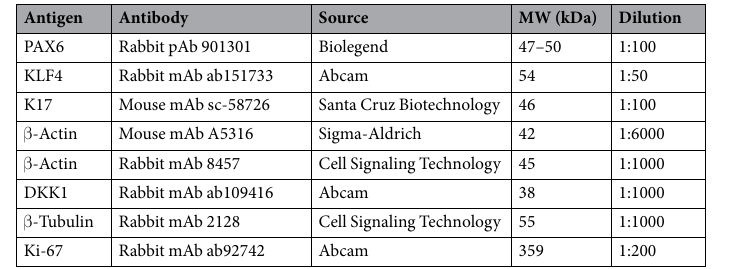
Table 2. List of antibodies used in this study. pAb, polyclonal antibody; mAb, monoclonal antibody.